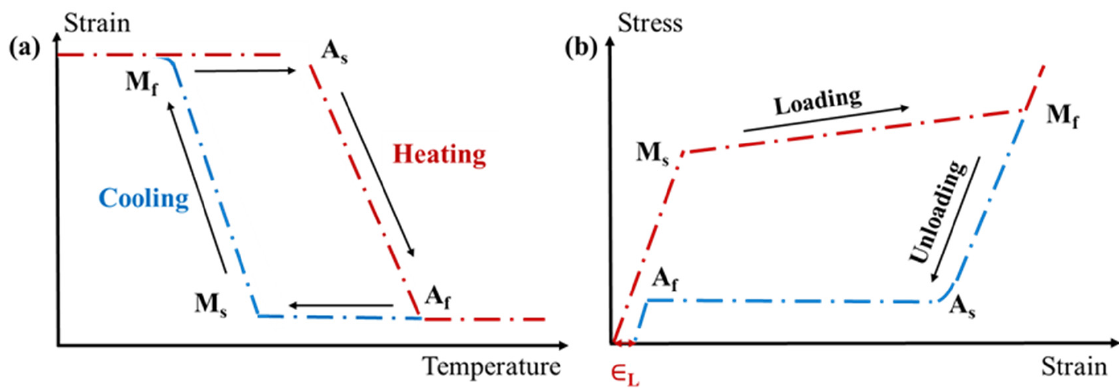
Figure 1. ( a ) The one-way shape memory effect of SMA wire. ( b ) Superelastic effect at a constant temperature. M s and M f are the start and finish martensitic phase temperatures, respectively; A s and A f are the start and finish austenitic phase temperatures, respectively.